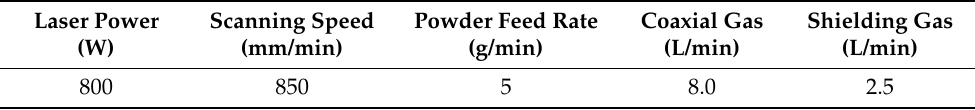
Figure 1. Schematic diagram of the directed energy deposition (DED) process. Table 1. DED process